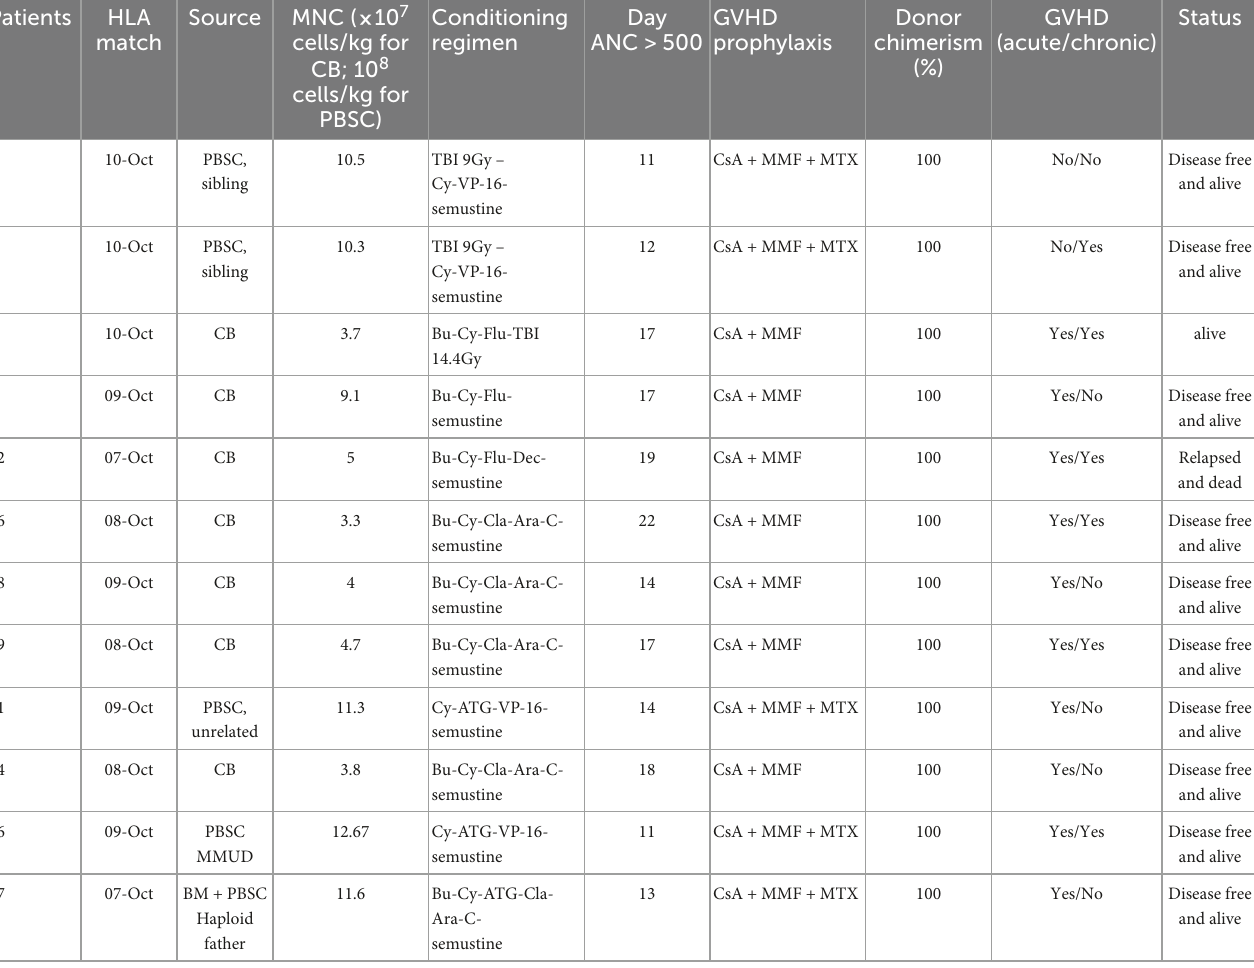
TABLE 2 Hematopoietic stem cell transplantation (HSCT) management and outcomes of the 12 high-risk patients.